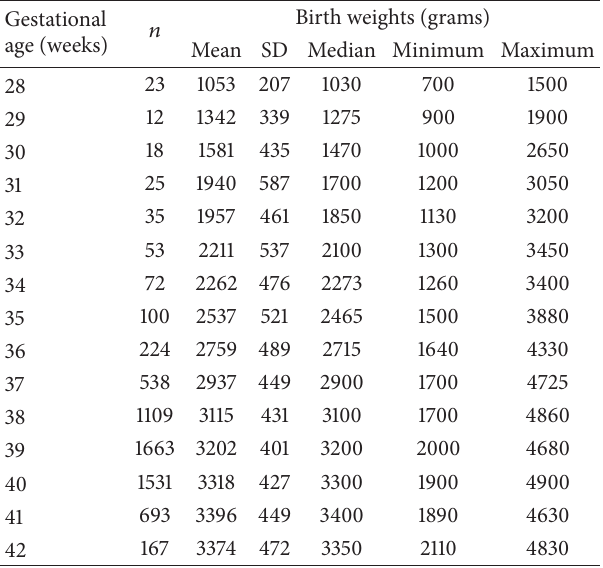
Table 2: Distribution of crude birth weights for gestational age for female Cameroonian infants.